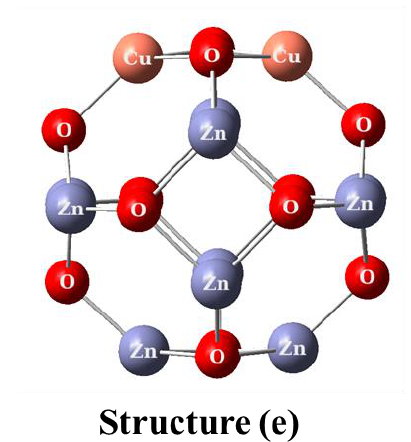
Figure 1. The isomeric structures of the Cu 2 Zn 10 O 12 cluster.